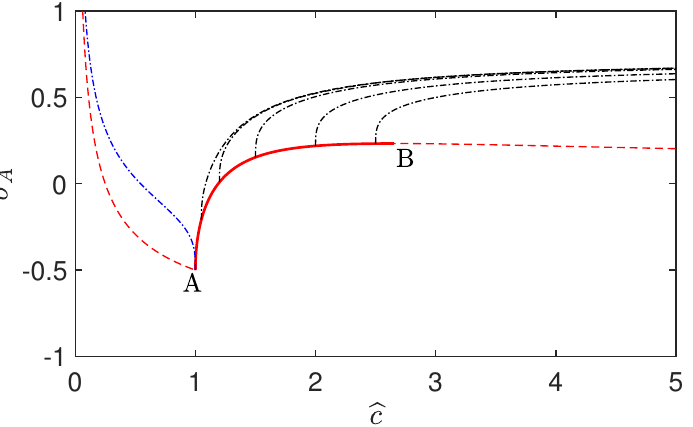
Figure 3. Unloading curves of the dimpled surface starting from different initial conditions (cid:98) c 0 = · = 0.5, n = 0.5 and [ 1.05,1.2,1.5,2,2.5 ] for α (cid:98) σ A = 1. Red lines for the Griffith elastic solution, d dot-dashed black lines for the rate-dependent model unloading curves.